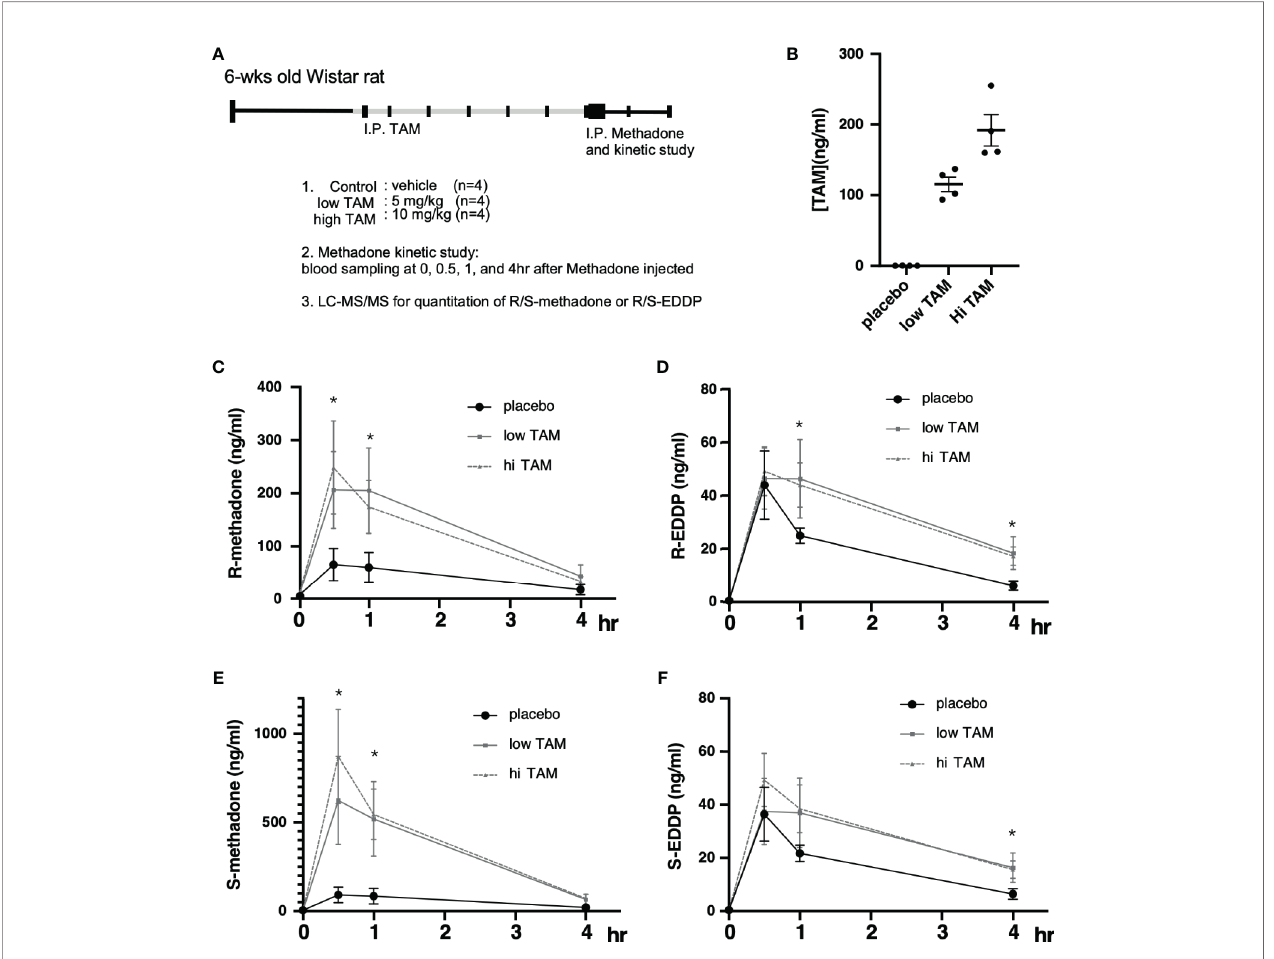
FIGURE 3 | Pharmacodynamic alterations in methadone metabolism with or without tamoxifen (TAM) injections. (A) Experimental design and treatment procedures. The 6-wk-old Wistar rats were randomly assigned to each of the study groups. First, TAM injections (control; low, 5 mg/kg; or high, 10 mg/kg) were injected for 6 days, followed by 10 mg/kg methadone on day 7, and blood was drawn at 0, 1, 2, 3, and 4 h after methadone injection to measure R/S-methadone, R/S-EDDP, and TAM using LC – MS/MS. (B) The serum TAM levels were measured at 4 h after methadone injection. (C) The serum R-methadone levels were measured in each group. (D) The serum R-EDDP levels were measured in each group. (E) The serum S-methadone levels were measured in each group. (F) The serum S-EDDP levels were measured in each group. The **** indicates a signi fi cant p-value < 0.00001, obtained using two-way ANOVA to compare groups. *I.P: intra-peritoneal injection. The * indicates a signi fi cant p-value < 0.05, obtained using two-way ANOVA to compare groups. I.P., intra-peritoneal